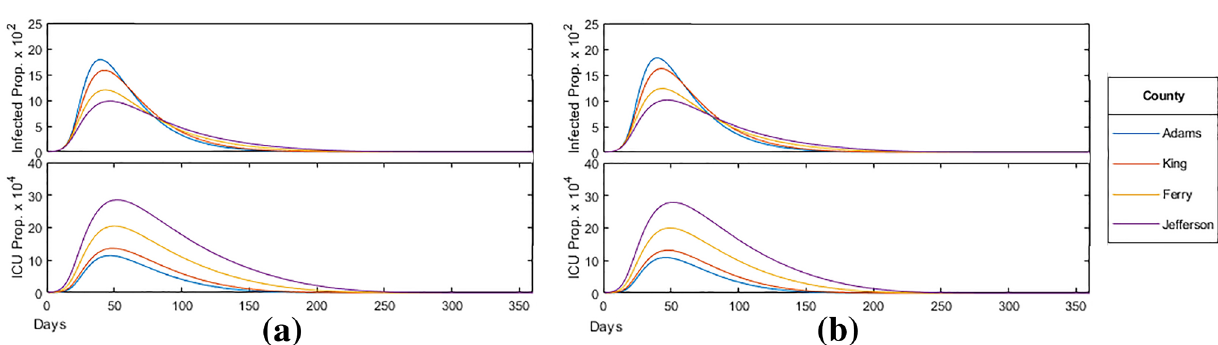
Figure 16. ( a ) Homogeneous vaccine distribution ( ω = ω C ); ( b ) moderate priority distribution ( ω = ω M